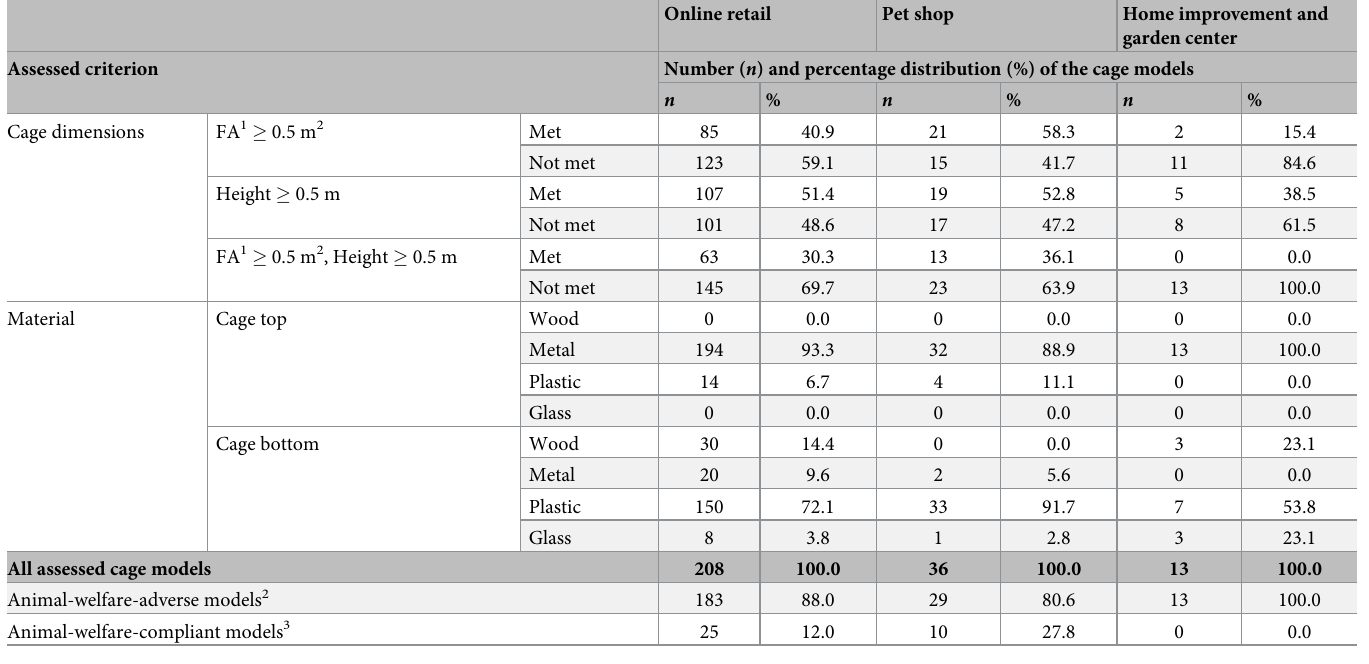
Table 4. Cage models purchasable from German retailers (online via internet shops, on site in pet shops or home improvement and garden centers) and their suit- ability for animal-appropriate housing of one golden hamster (minimal dimension requirement for housing a small mammal species) and specific design